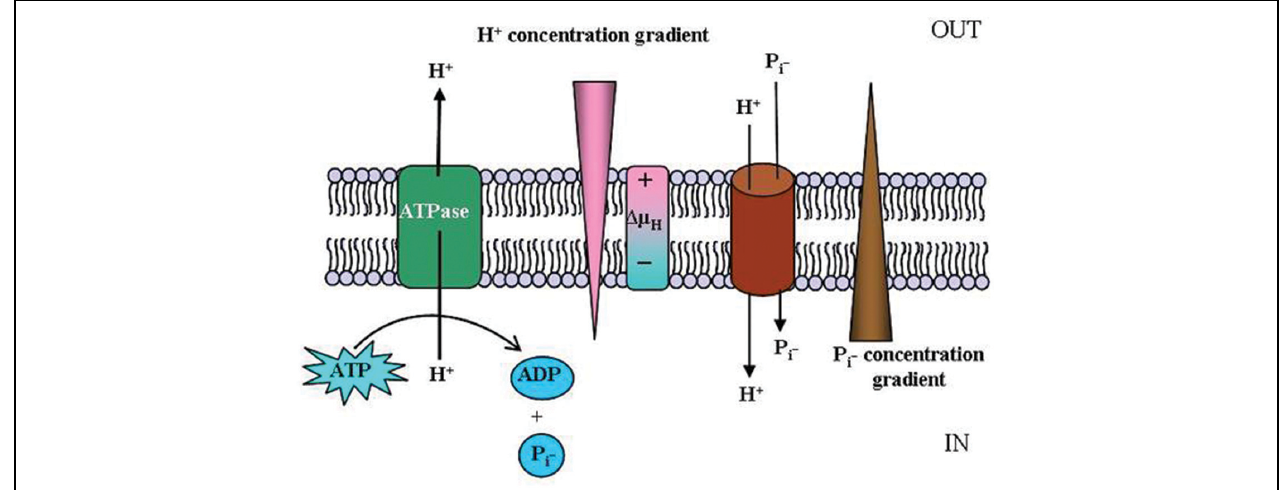
FIGURE 2 | Pi uptake mechanism across the plasma membrane. A membrane-integral proton ATPase uni-directionally extrudes protons (H + ) at the expense of ATP (primary transport). The generated proton concentration gradient and membrane potential constitute a proton electrochemical potential ( (cid:2) μ H ) across the membrane. Proton movement along concentration and electrical gradients facilitates Pi (Pi − ) allocation through Pi transporters against a steep concentration gradient (secondary transport; Karandashov and Bucher, 2005).